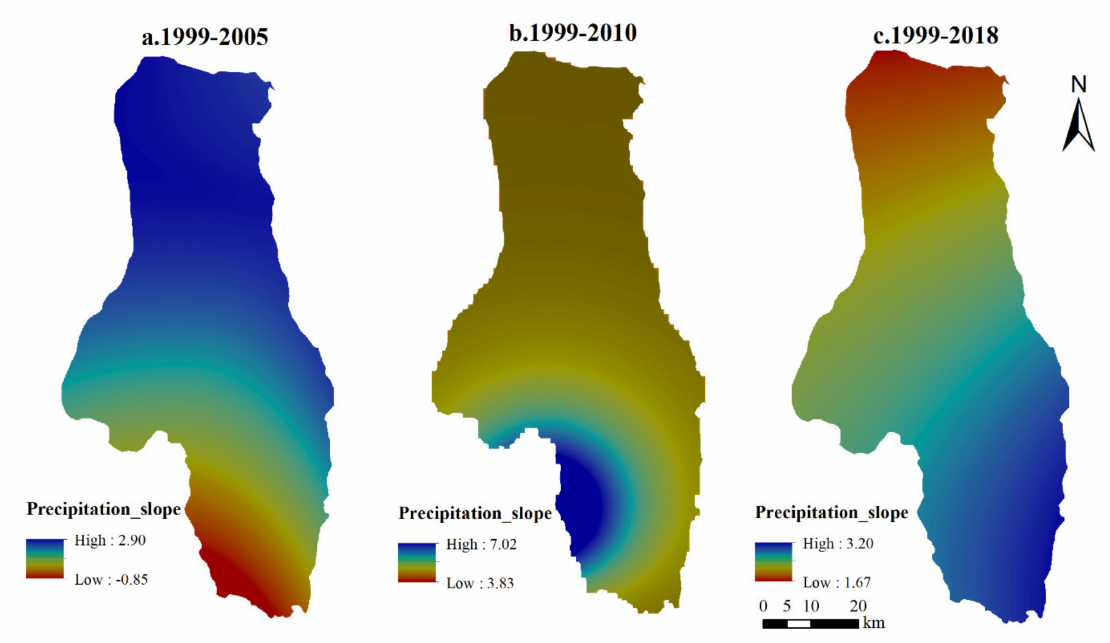
Figure 8. ( a – c ) Spatial distribution of precipitation slope by Kriging interpolation. Precipitation data in 1999–2018 were acquired from five meteorological reference stations: Hanjinqi, Linhe, Huinong, Etuokeqi, and Taole. Precipitation slope was obtained by linear regression based on interannual precipitation data, and then imported into ArcGIS to obtain changes in the study area by Kriging